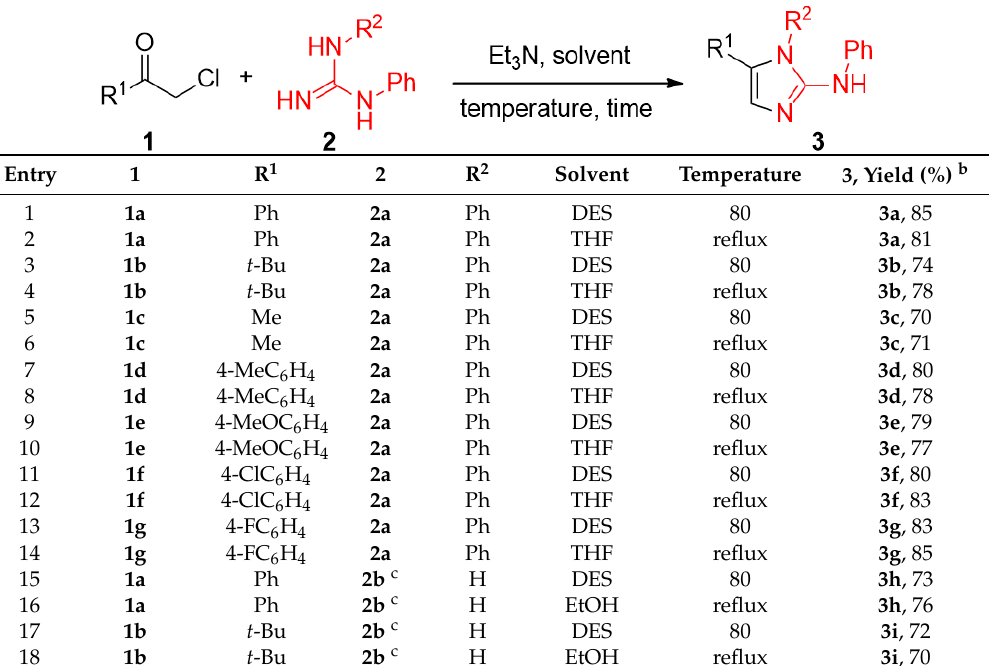
Table 1. Synthesis of 2-aminoimidazoles 3 in a DES mixture or in other solvents a .